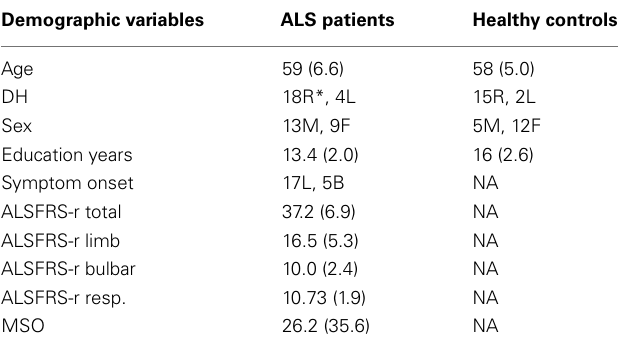
Table 1 | Means and SD for demographic information by